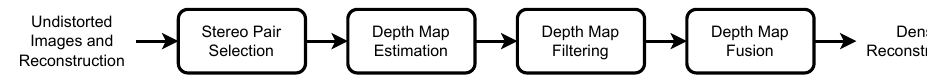
Figure 15. Diagram representing the applied Multi View Stereopis